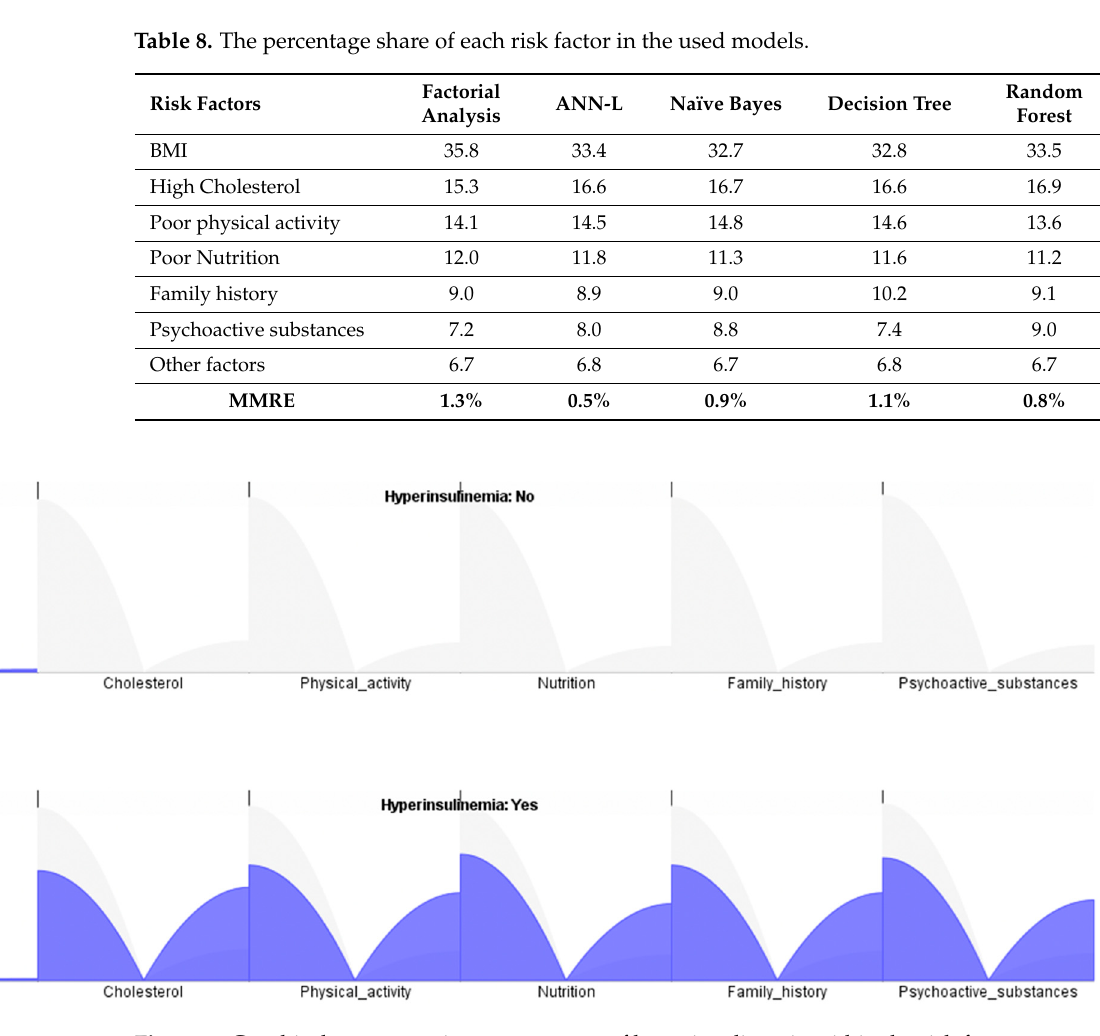
Figure 8. Graphical representation—occurrence of hyperinsulinemia within the risk factors assessed by ANN-L—experimental and control group.